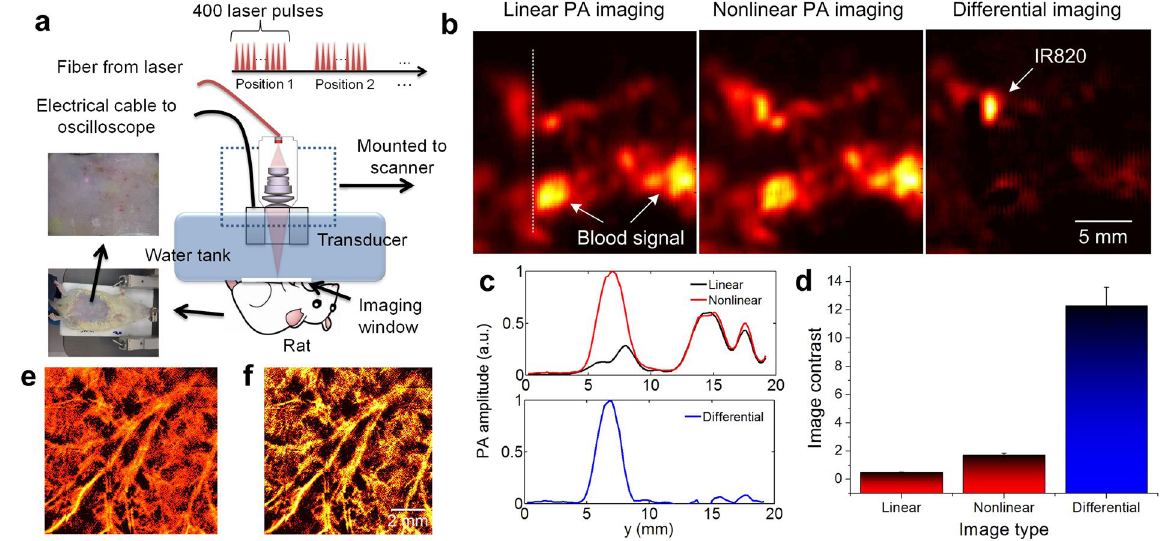
Figure 6. ( a ) In vivo experimental setup based on the LDPA technique by quasi-CW laser excitation. ( b ) The reconstructed linear PA, nonlinear PA and differential imaging results of a rat with subcutaneous injection of IR820 in the abdomen. Strong PA signals from high-absorptive blood background are shown in the linear and nonlinear PA images. By subtracting, the signal from the IR820 pops up with linear background suppression. ( c ) Normalized signal intensity of the linear, nonlinear and differential images along the white dashed line in b. ( d ) The image contrast comparison of the three images in b. ( e ) The linear PA imaging and ( f ) nonlinear PA imaging results of the ear